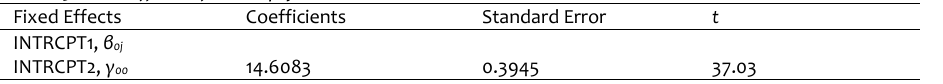
Table 3 .Fixed Effects of the Empty Model